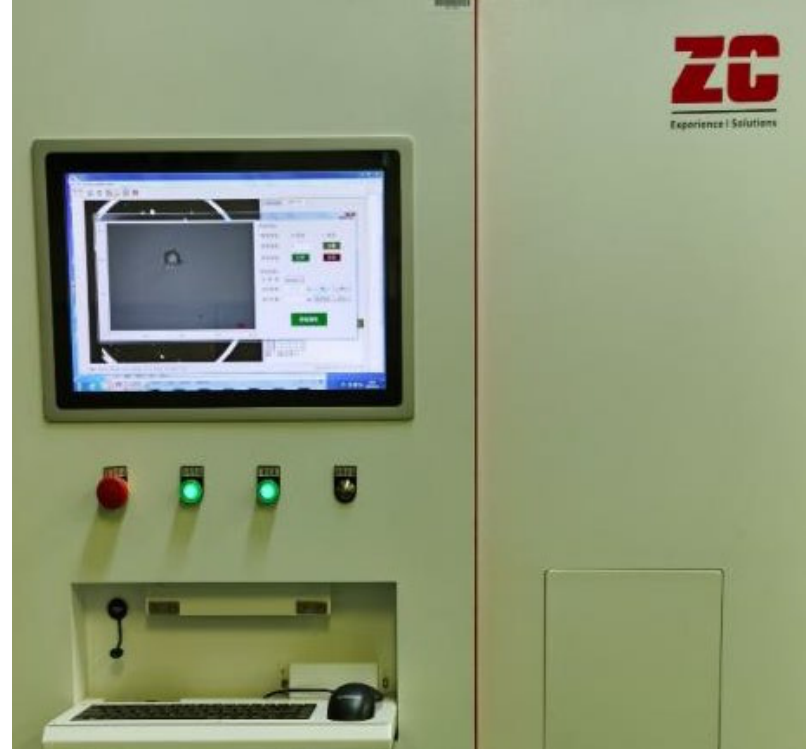
Figure 2. Ultra-smooth surface laser scattering quality detection device.